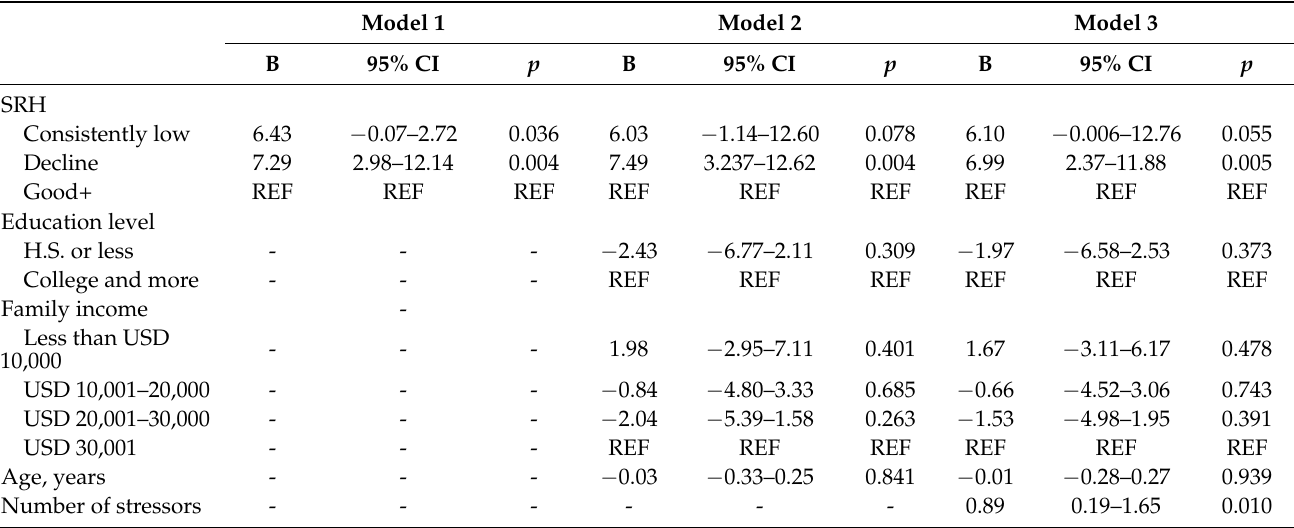
Table 5. Crude and Multiple Adjusted Linear Regression Models Examining Associations between Change in Self-Rated Health and Prenatal Anxiety